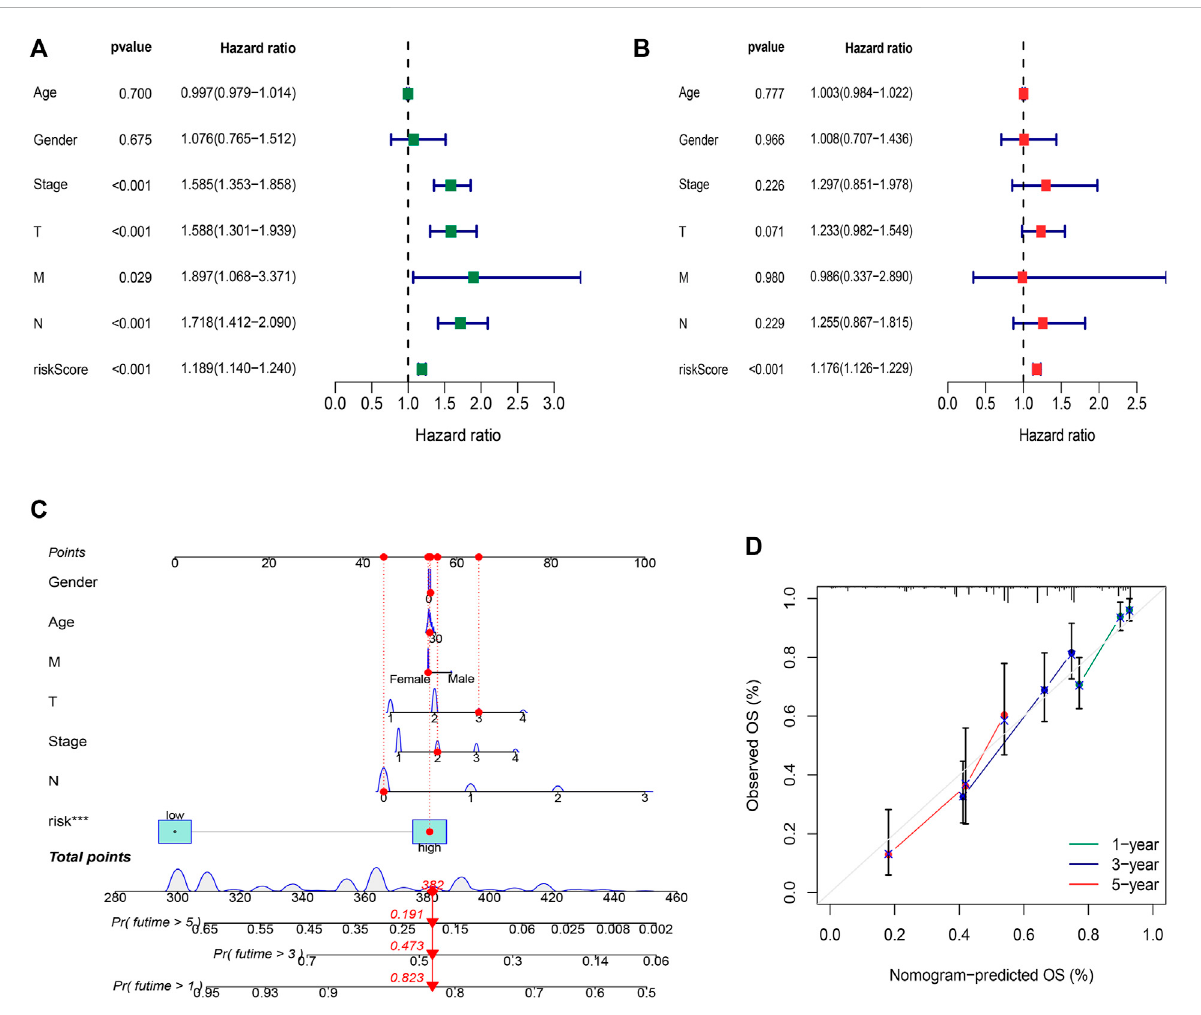
FIGURE 6 Construction and validation of the nomogram. (A) Univariate Cox regression analysis indicated that disease stage, T stage, M stage, and risk score,wererelatedtoprognosis( p < 0.001) (B) MultivariateCoxregressionanalysispresentedthattheriskscorewasanindependentfactoraffecting prognosis ( p < 0.001). (C) The nomogram predicts the probability of the 1-, 3-, and 5-year OS. (D) The calibration